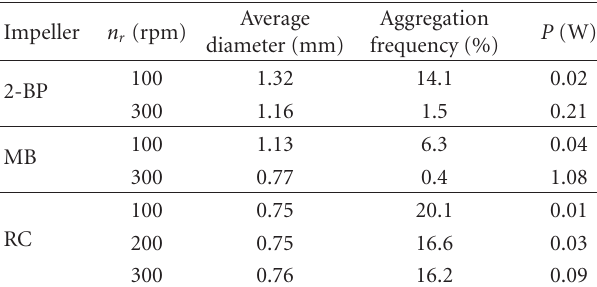
Table 2: The summary of experimental results. The average diam- eter means the overall average value of all TBAB hydrate particles observed in each experimental